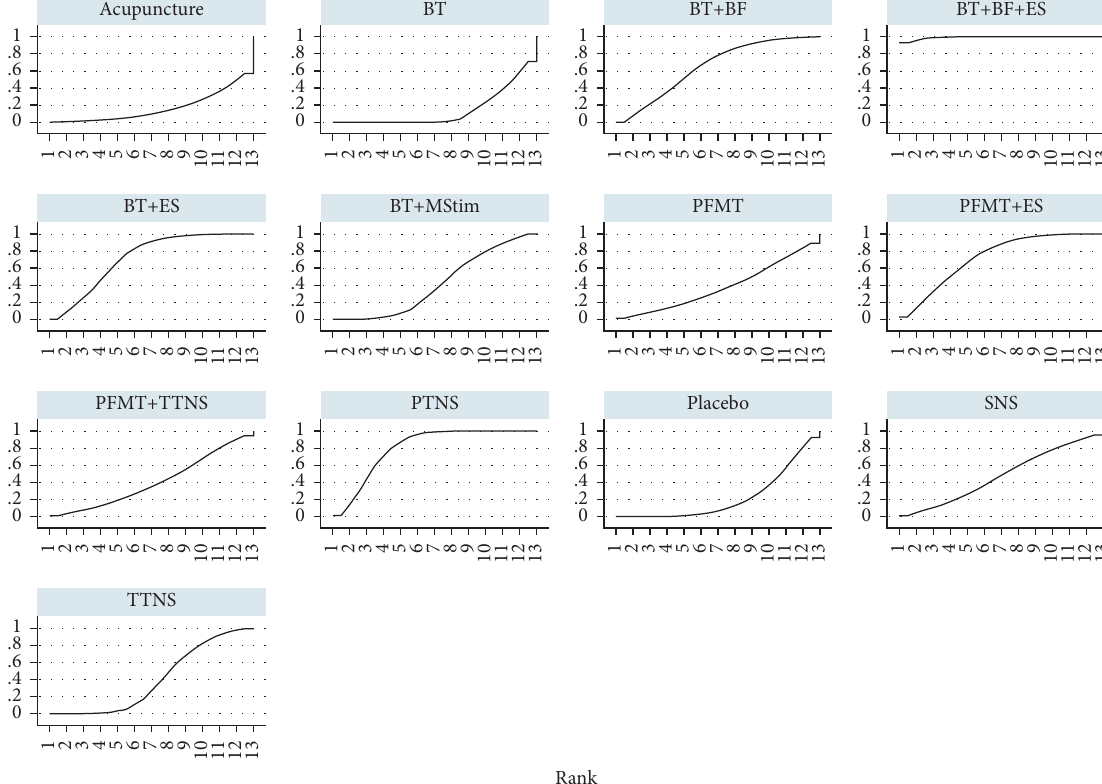
Figure 8: Cumulative ranking curves for nocturia